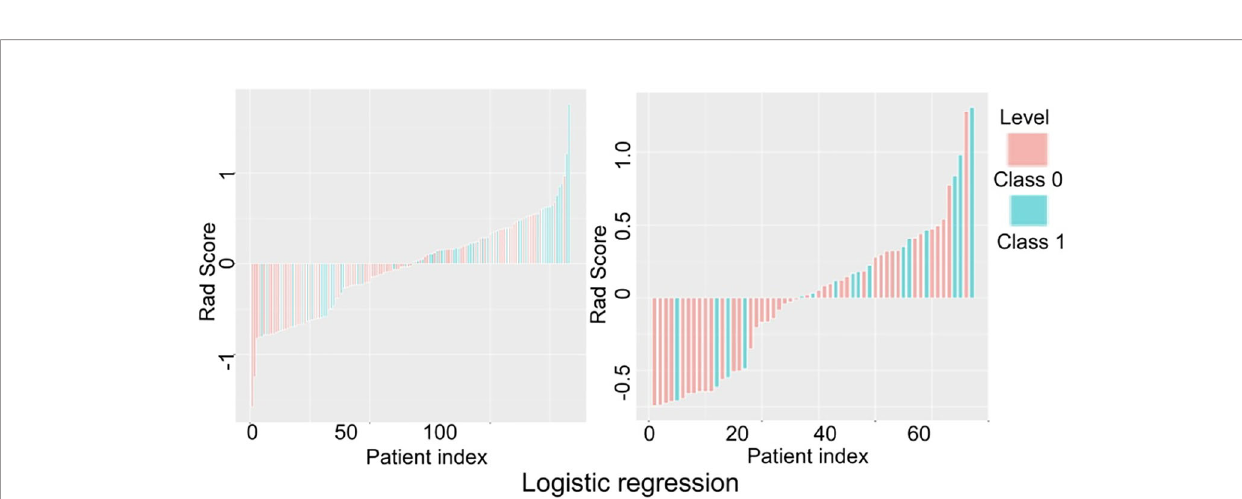
FIGURE 5 | Veri fi cation and comparison of the logistic regression model in predicting low and high grade renal cell carcinoma in the training and testing set. In the training set, the true negative rate (speci fi city) for predicting grade I-II clear cell renal cell carcinoma (ccRCC) was 60.5% (49/81), and the true positive rate (sensitivity) for predicting grade III-IV ccRCC was 65.4% (34/52). In the testing set, the true negative rate was 53.7% (22/41) for predicting grade I-II ccRCC and 75% (12/16) for predicting grade